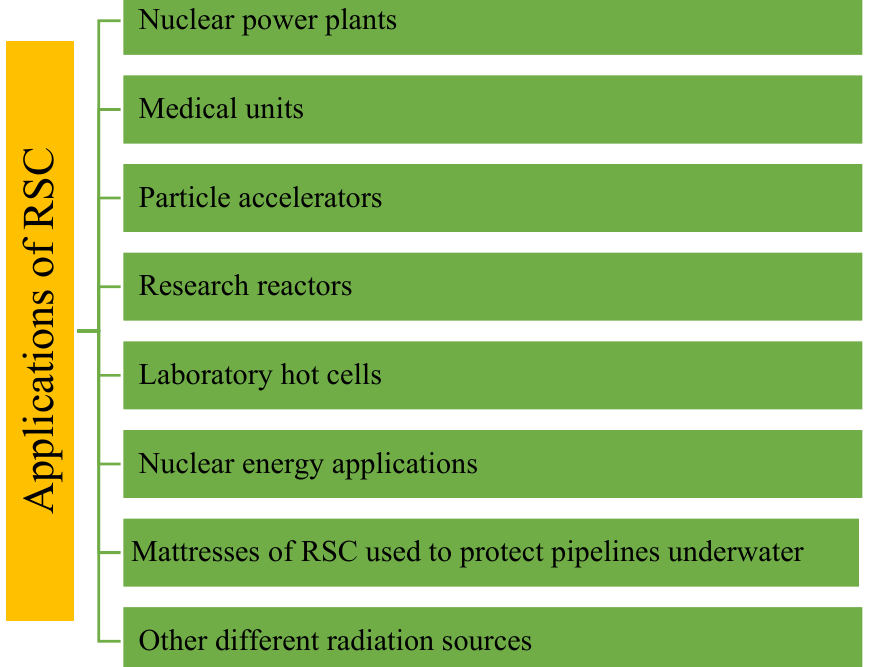
Figure 20. Applications of RSC.